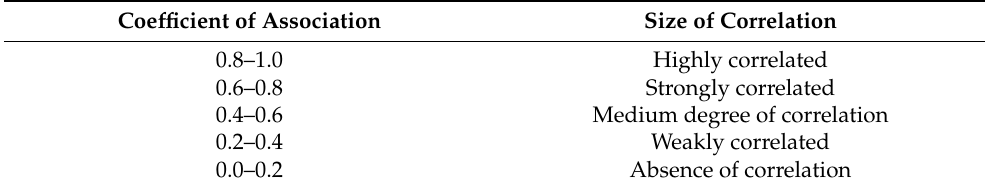
Table 2. Similarity evaluation